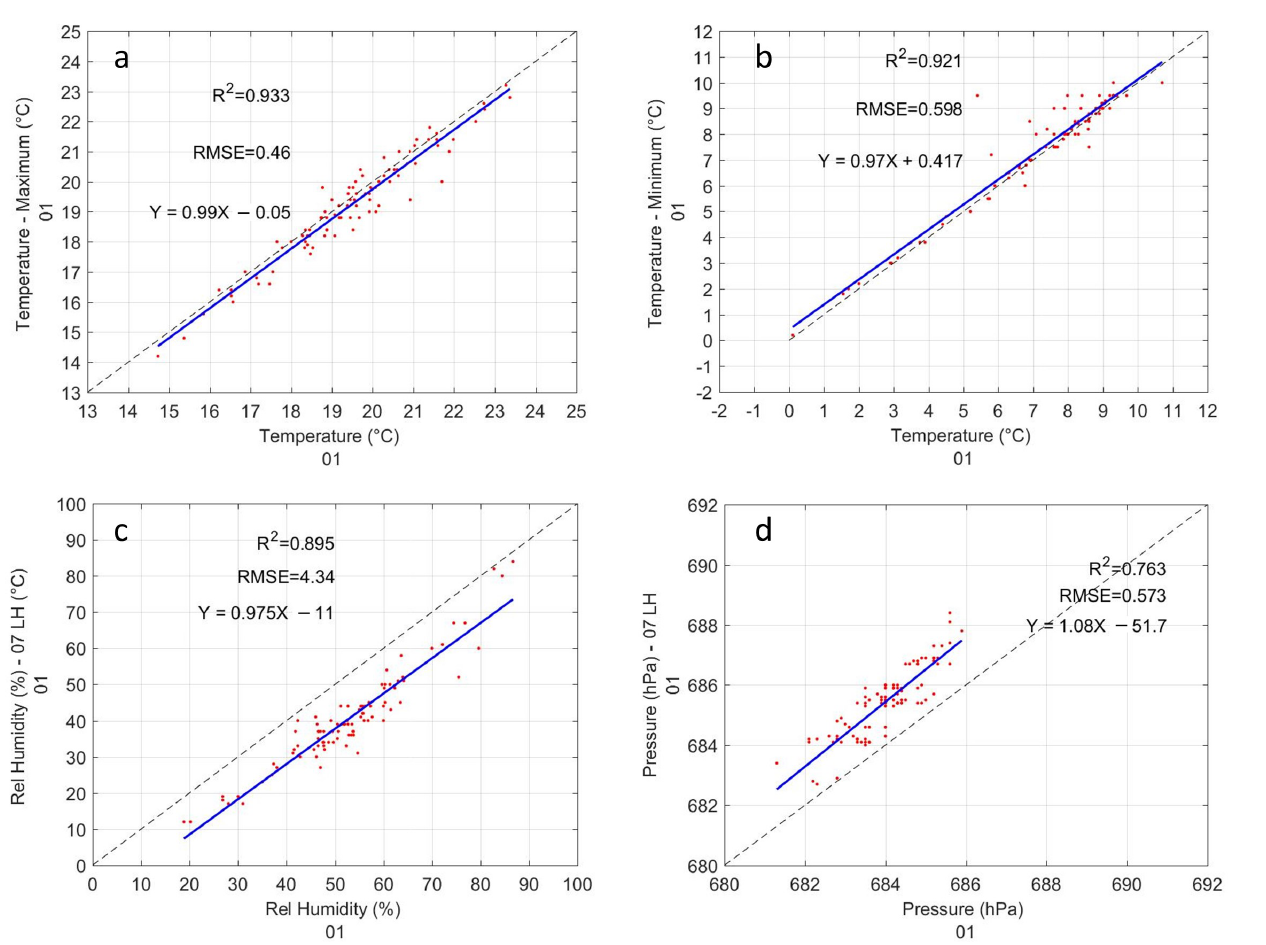
Figure 7. Evaluation of GMX500 sensor 01 with a conventional weather station: ( a ) Minimum temperature. ( b ) Maximum temperature. ( c ) Pressure. ( d ) Relative Humidity. The linear regression is shown in blue